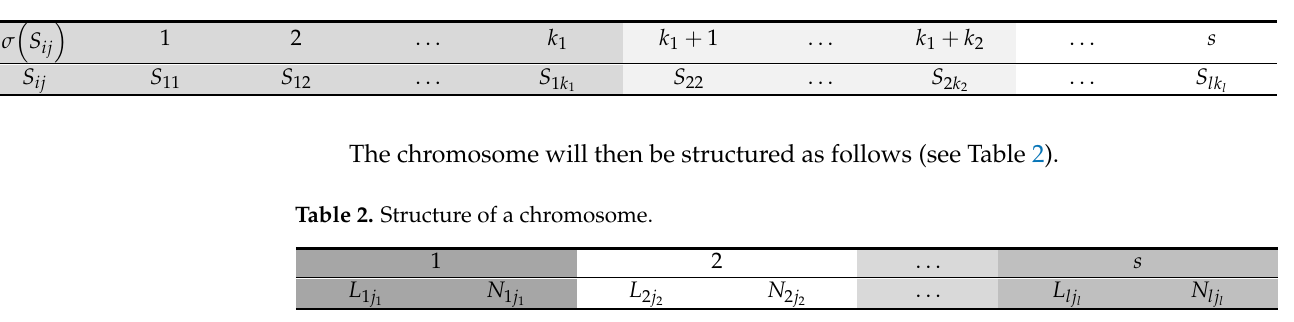
Table 1. σ ( i ) Function.